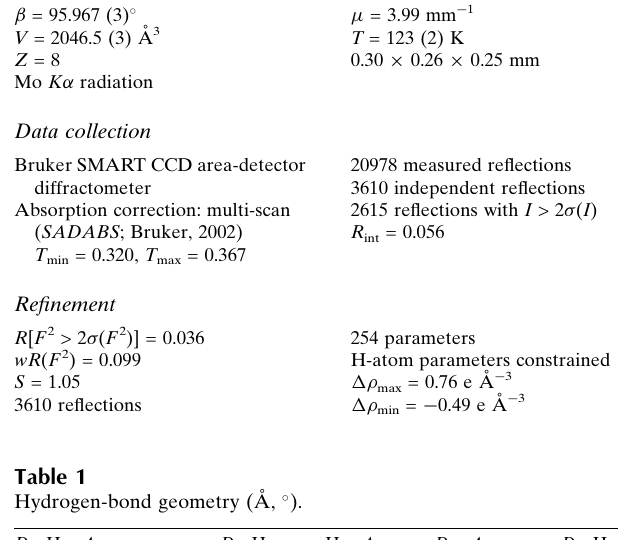
H BrN O , crystallizes with two 9 9 2 2